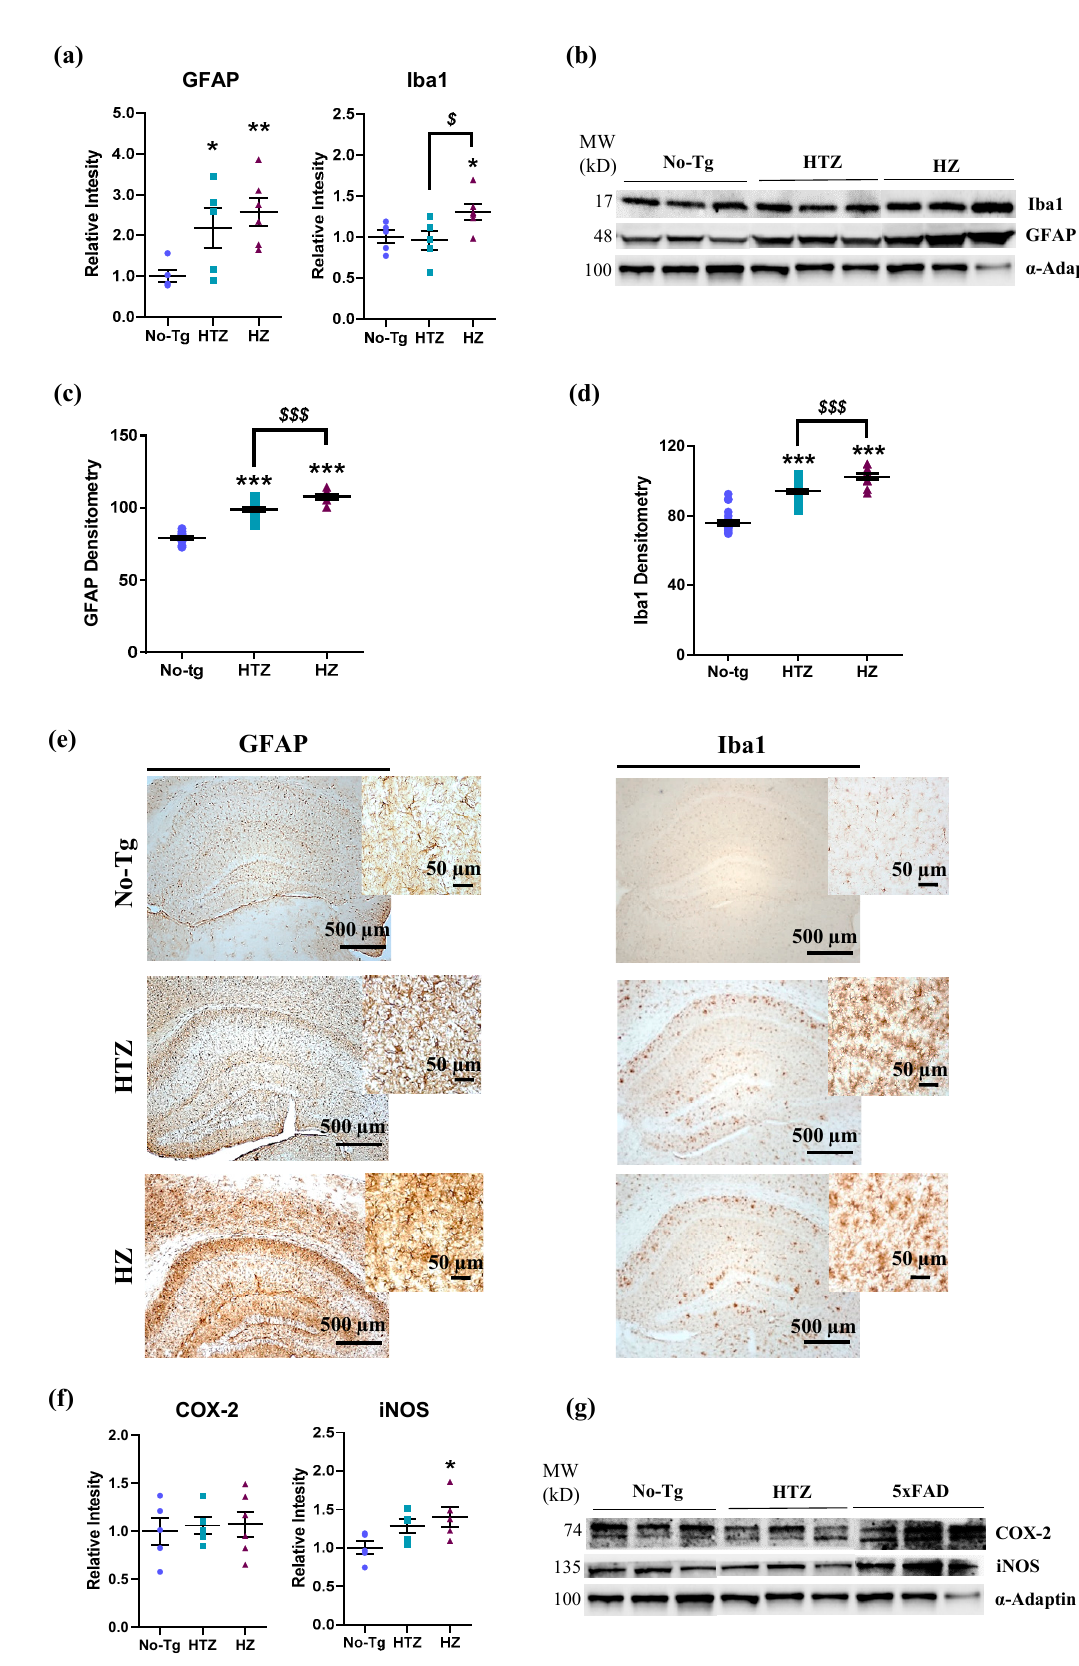
Figure 5. Neuroinflammation response in both heterozygous and homozygous 5xFAD transgenic mice. Bar charts in ( a ) represent the quantification of Western blot membranes ( b ) after incubating with anti-glial fibrillary acidic protein (GFAP) and ionized calcium-binding adaptor molecule 1 (Iba1), and